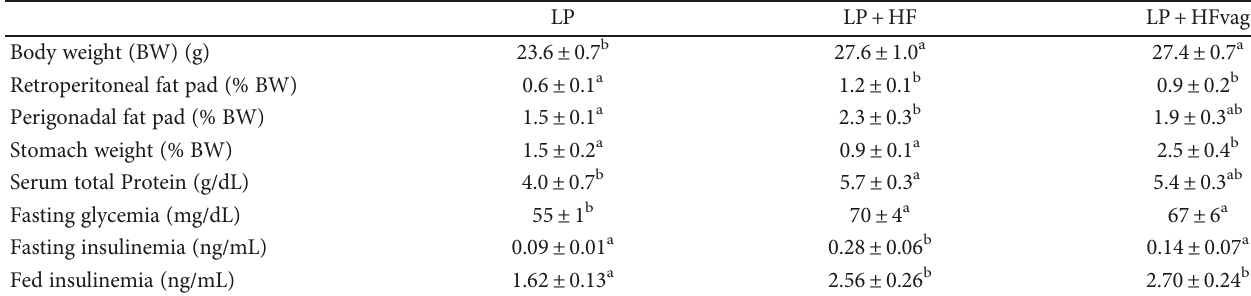
Table 1: Body, fat pads, and stomach weight, followed by blood glucose and plasma insulin concentration in the LP, LP +HF, and LP +HFvag mice.